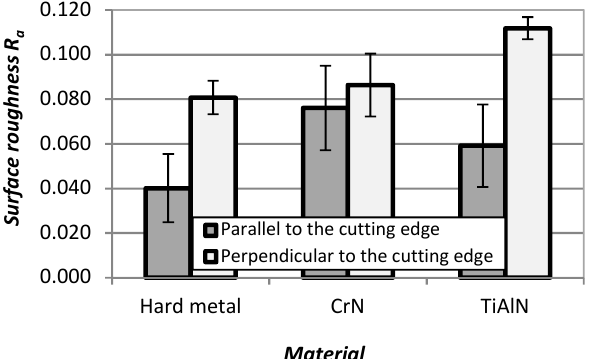
Figure 4. Roughness of WC-Co cutters with and without PVD coatings in the parallel and perpendicular directions to the cutting edge.